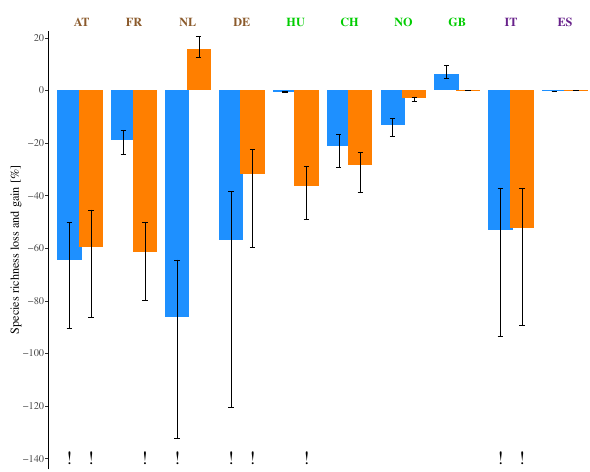
Fig. 3 Comparative change in species richness (sum of vascular plant, earthworm, spider and bee species) by aiming at a 10% production increase in organic and non-organic systems of ten European farmland regions (brown: arable crops, mixed systems, and horticulture, bright green: grassland, violet: permanent crops). Net loss and gain of species (sum of vascular plant, earthworm, spider and bee species) by conversion of semi-natural habitats to production fi elds to achieve 10% more production than the non-organic level for non-organic systems (blue bars) and for organic systems (orange bars). Exclamation marks indicate a total conversion of semi-natural habitats without reaching 10% production increase. Species loss and gain are derived from sample size based extrapolation (Methods). Con fi dence intervals (95%) are the sum over the con fi dence intervals of the four species